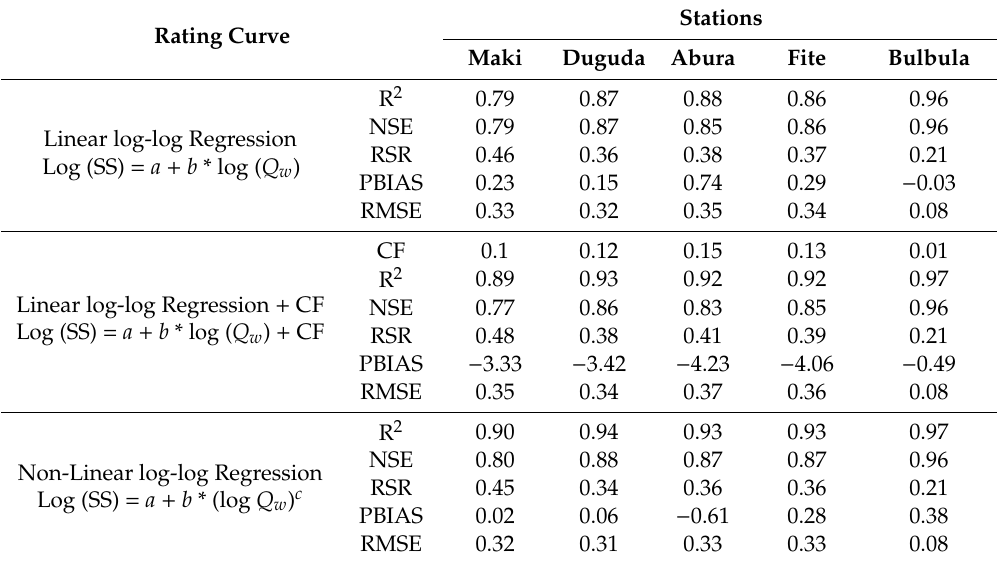
Table 2. Developed rating curves for river monitoring